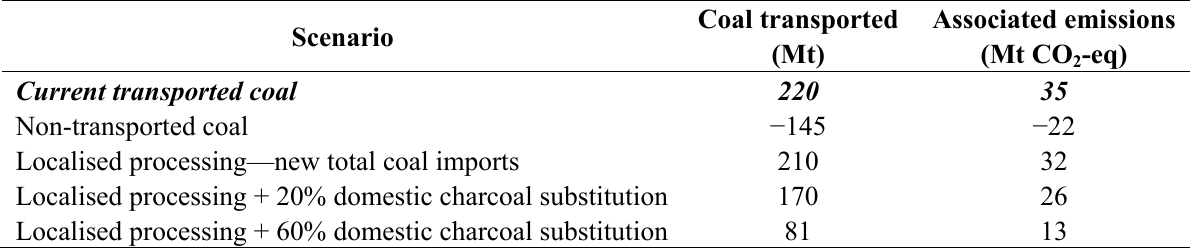
Table 5. Coking coal transport under a localization strategy for steel